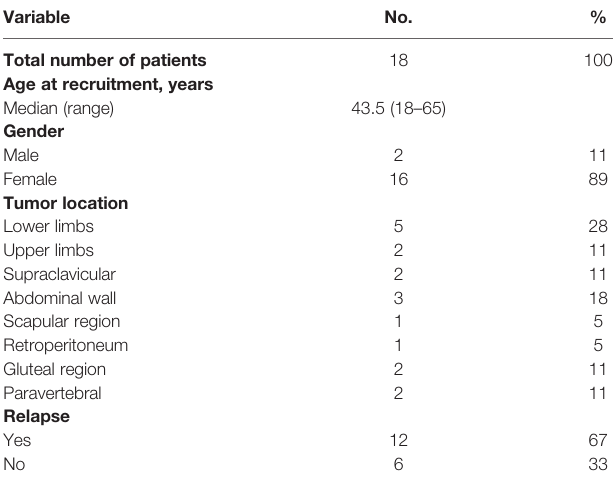
TABLE 1 | Clinical characteristics of the